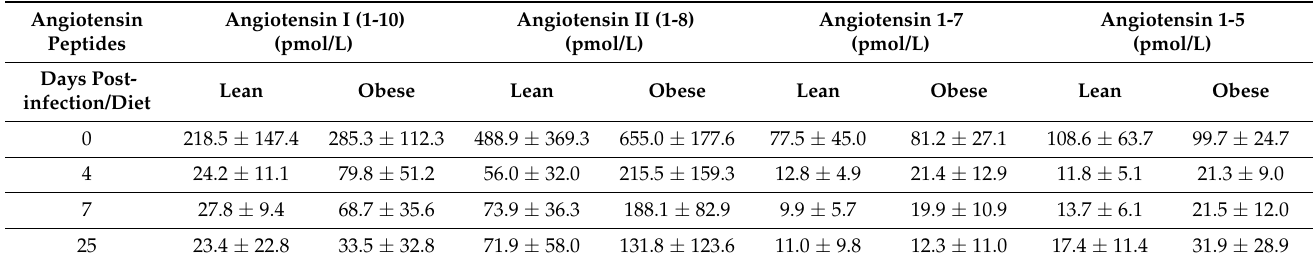
Table 3. Equilibrium levels of circulating angiotensin peptides. Values are expressed in mean ± SD ( n = 6–8